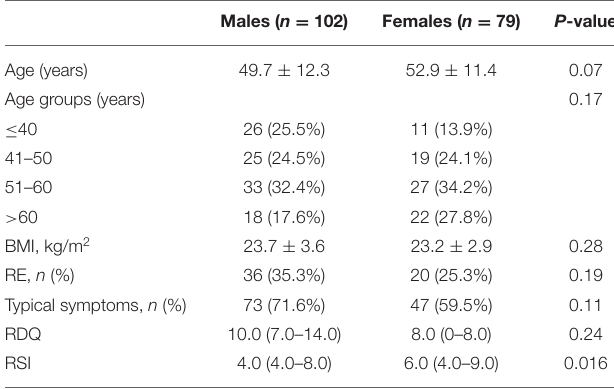
TABLE 1 | Demographics and clinical characteristics according to